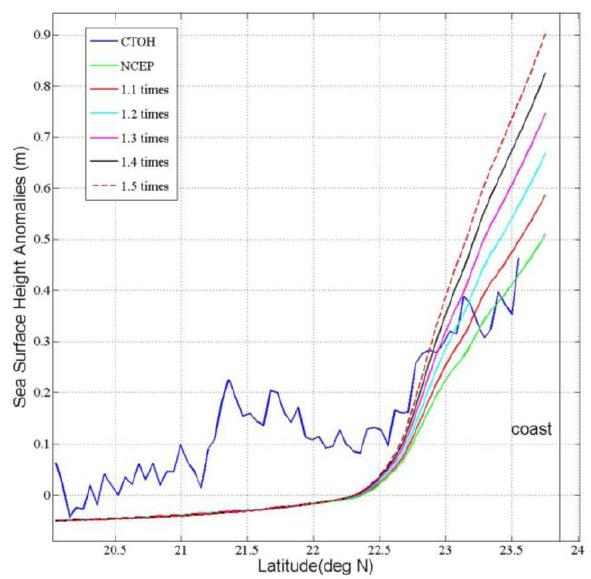
Figure 6. De-tided altimetric and model surface height anomalies for Cycle 76 during Hurricane Seth, relative to those averaged for Cycle 75 and 77.